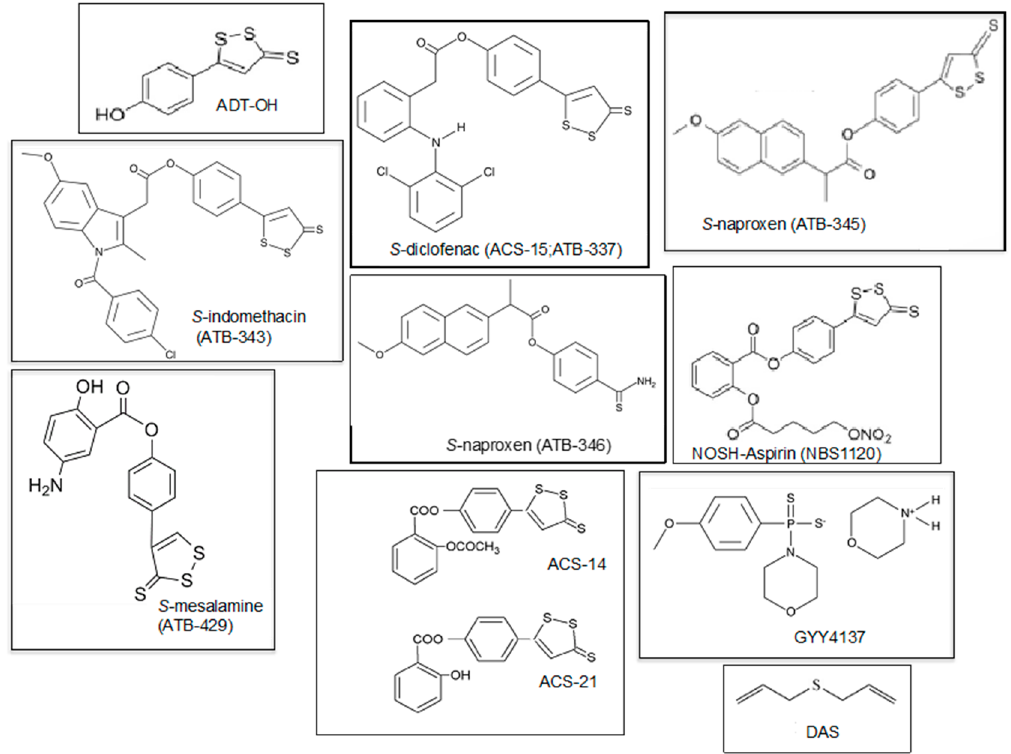
Figure 4. Molecular structures of slow H 2 S-releasing agents with potential anti-inflammatory properties for the treatment of arthritis. ADT-OH (5-(4-hydroxyphenyl)-3 H -1,2-dithiole-3-thione) and ATB-429 ([4-(5-sulfanylidenedithiol-3-yl) phenyl] 5-amino-2-hydroxybenzoate) are H 2 S-releasing derivatives of mesalamine. ATB-337, ATB- 343, and ATB-345 are respectively diclofenac, indomethacin, and naproxen linked to a hydrogen sulfide-releasing moiety. ATB-346 is naproxen covalently linked to 4-hydroxythiobenzamide (TBZ). ACS-14 is aspirin linked to H 2 S donors, ACS-21 is deacetylated aspirin linked to H 2 S donors, and NBS1120 is a NO H 2 S-releasing derivative of aspirin. GYY4137—morpholin-4-ium 4 methoxyphenyl phosphinodithioate; DAS—diallyl sulfide .